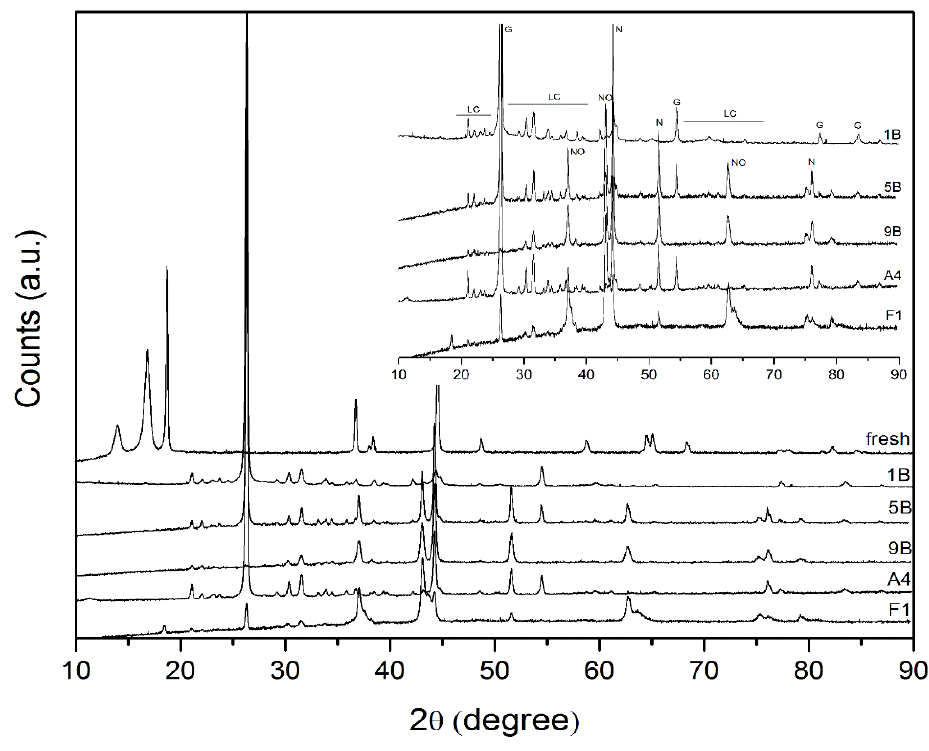
Figure 10. XRD spectra of cathode before (new) and after thermal abuse tests (1B, 5B, 9B, A4, F1), with relative zoom. (G = graphite, LC = Li 2 CO 3 , N = Ni, NO = nickel oxide).